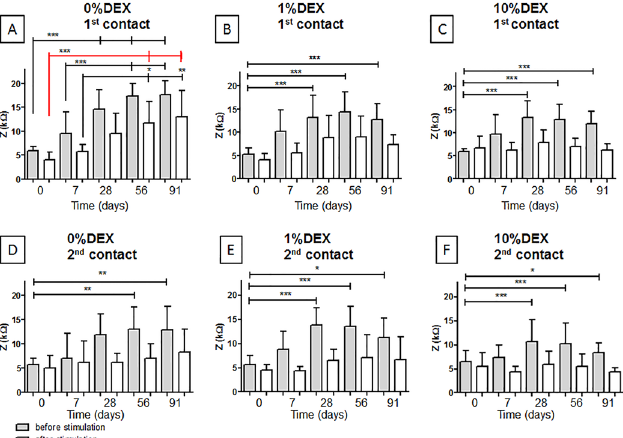
Fig 4. Mean impedance (y-axis) before and after 60 minutes of ES are plotted for all measurement days (x-axis). Sections A-C show the impedances at the first contact (basal, near to the RWN) for each experimental group whereas sections D-F visualize the impedances at the second, more apical, contact. Statistical differences in impedances between the experimental days were denoted: * = p < 0.05; ** = p < 0.01; *** = p < 0.001; error bars =